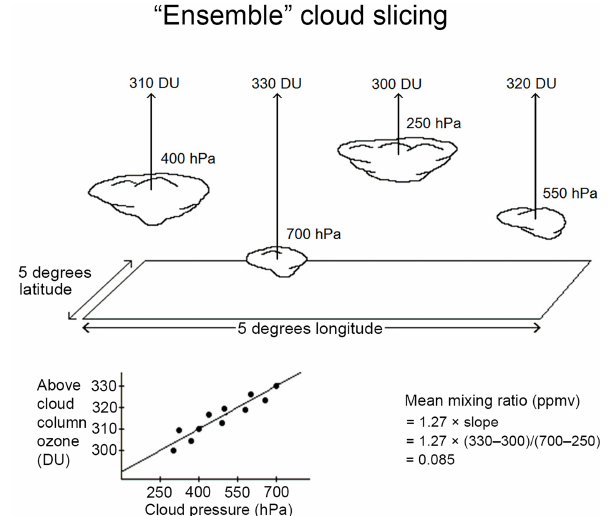
Figure 1. A schematic diagram illustrating the ensemble cloud slic- ing method involving coincident measurements of above-cloud col- umn ozone (i.e., column ozone measured from the top of the atmo- sphere down to cloud pressure) and cloud pressure to measure mean volume mixing ratio (see text). For deep convective cumulonim- bus clouds the cloud tops are near the tropopause and so the mean volume mixing ratio is primarily a measurement of average “in- cloud” ozone concentration. This figure was adapted from Ziemke et al. (2001). For our study all measurements are from OMI (i.e., OMI above-cloud ozone versus OMI